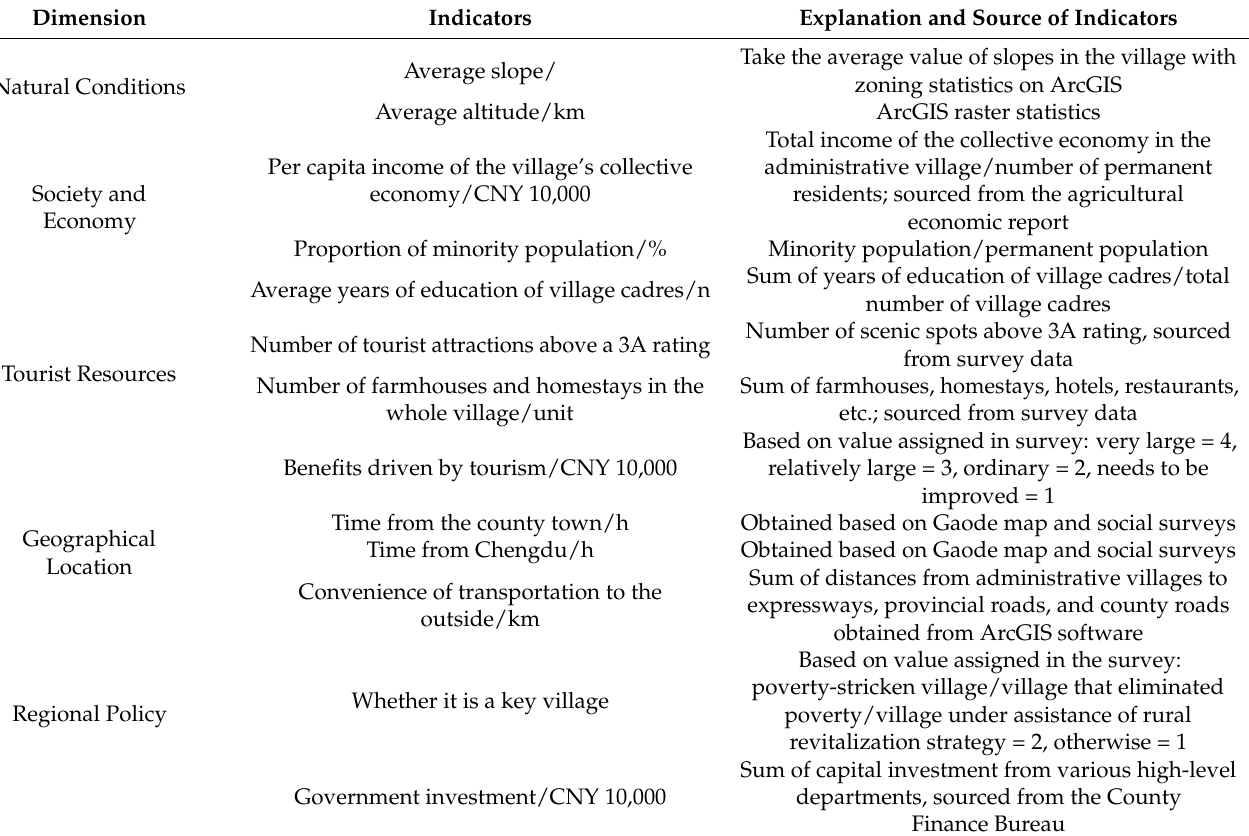
Table 2. Evaluation index system of factors that influence the spatiotemporal characteristics of land use for rural tourism in the study